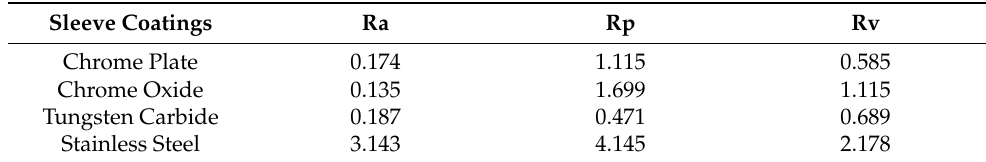
Table 7. Sleeve Surface Roughness (units: µ